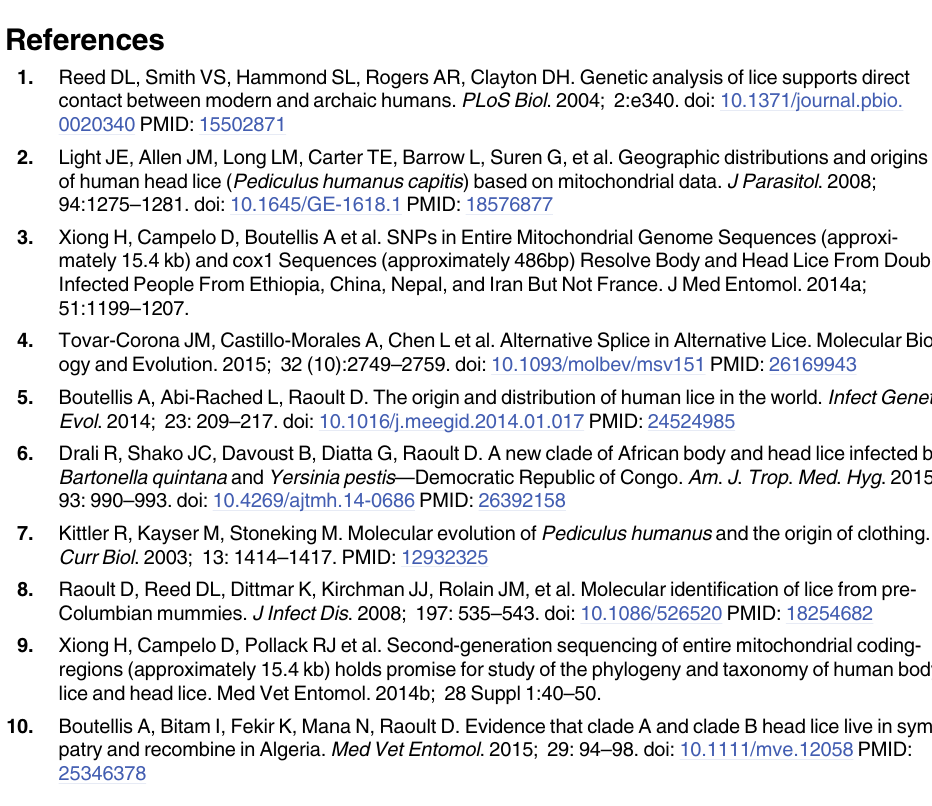
S1 Table. Geographic occurrences and frequencies of cytb haplotypes of human head and body lice. Haplotypes highlighted in blue are the newly identified haplotypes from sequences available in